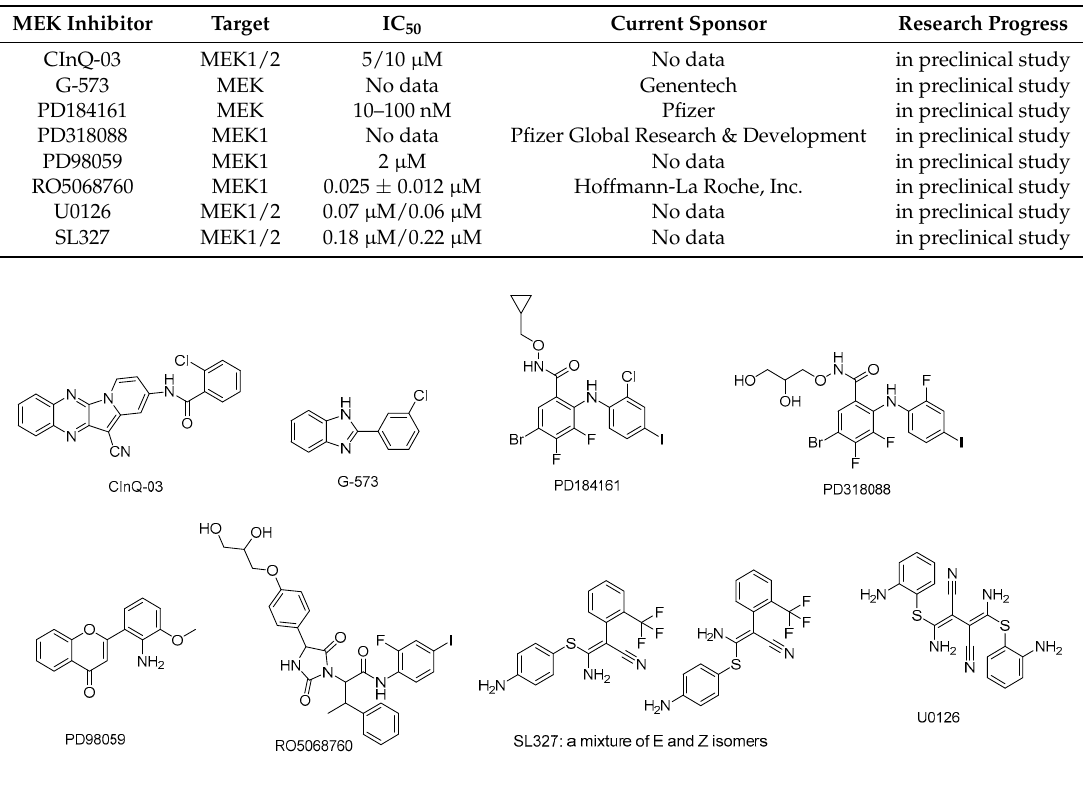
Figure 4. MEK inhibitors in preclinical study.